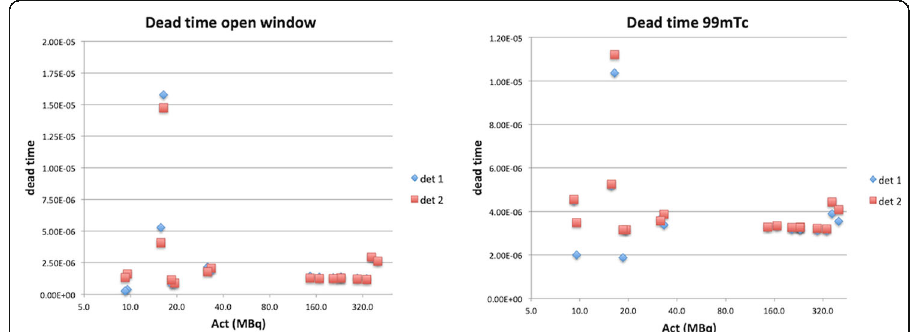
Fig. 2 Calculated dead time τ (s) vs. total activity (MBq) for the intrinsic measurement for both detectors for the open window (OW 0 – 1022 keV, left) and 99m Tc (126.5 – 154.6 keV, right) energy window